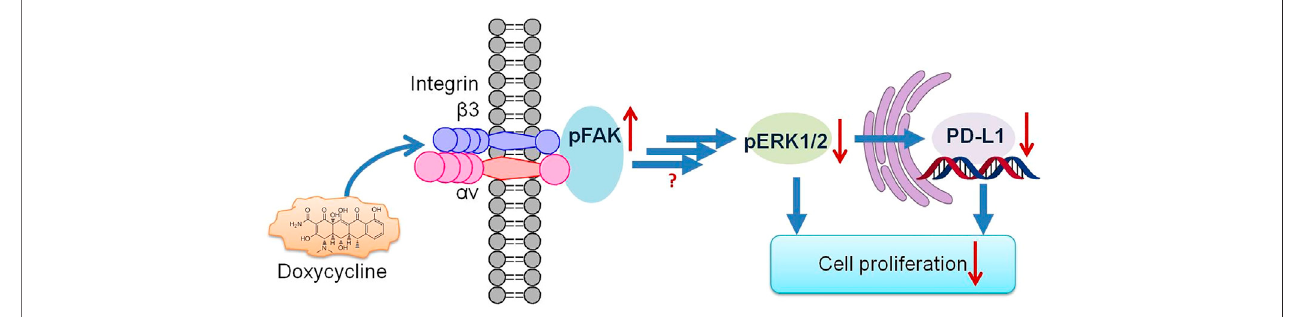
FIGURE 7 | The signaling pathways of doxycycline-induced anti-proliferation in human breast cancer MDA-MB-231 cells.